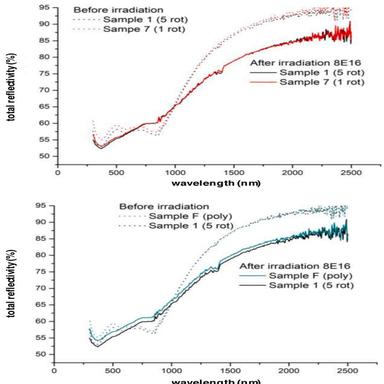
Total reflectivity of polycrystalline Mo-mirrors before and after irradiation with He+ ions: comparison of materials using severe plastic deformation via high pressure torsion with different rotations (top); comparison of industrially available (poly) and severe plastically deformated materials using 5 rotations (bottom).